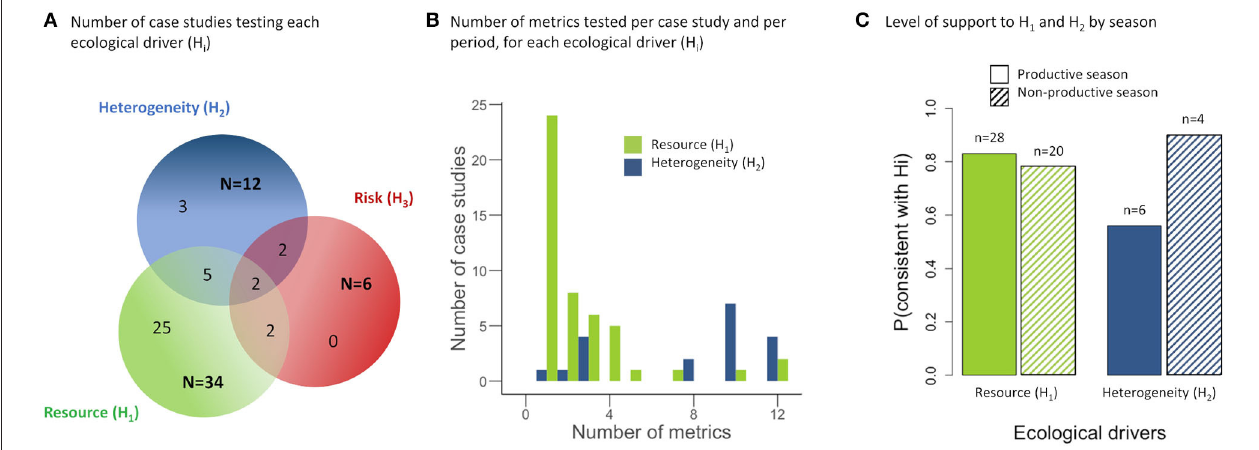
FIGURE 5 | Venn diagrams for (A) the number of case studies testing a relationship between the sizes of home ranges and resource, landscape heterogeneity or risk indices, and combinations of these. (B) Number of metrics tested per case study, per period, and for each ecological driver. (C) Proportion of case studies that contained at least one metric supporting the biological hypothesis, for each ecological driver and